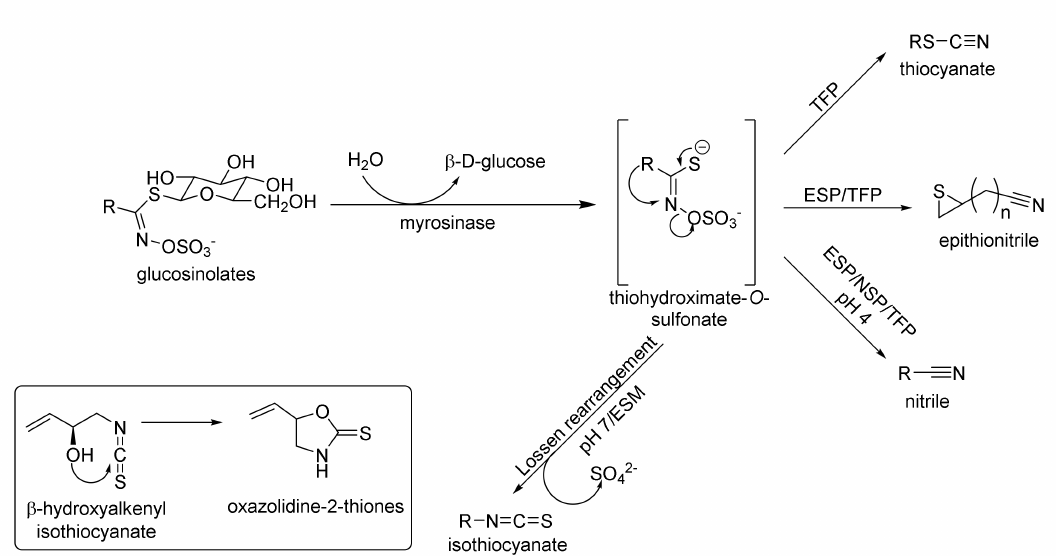
Figure 2. Enzymatic degradation of